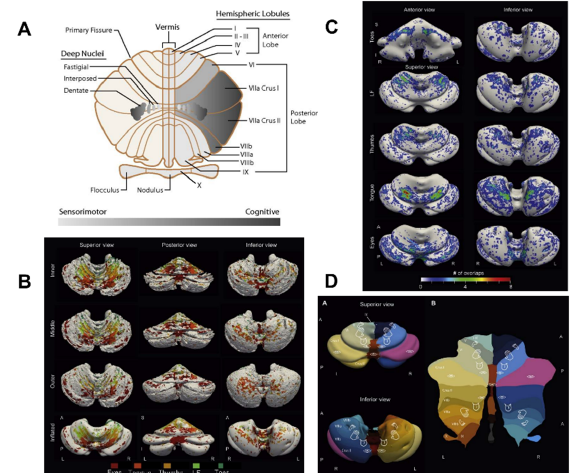
Figure 1. ( A ) scheme of cerebellar sensorimotor and cognitive topography. The cerebellum is divided into 10 lobules (I-X; classification of Larsell). Classically, the cerebellum has been divided into an anterior lobe (lobules I-V), a posterior lobe (lobules VI-IX) and a flocculo-nodular lobe (lobule X). The lateral portions of the cerebellum are particularly prominent in humans. ( B ) Somatomotor maps of the cerebellum obtained in healthy adults. L/R: left-right; A/P: anterior-posterior; S/I: superior-inferior. ( C ) Inflated surface on which the number of overlaps for each body part is mapped. ( D ) Illustration of the somatotopic organization (superior view, inferior view, and flatmap). Figure 1B-D: from [14].